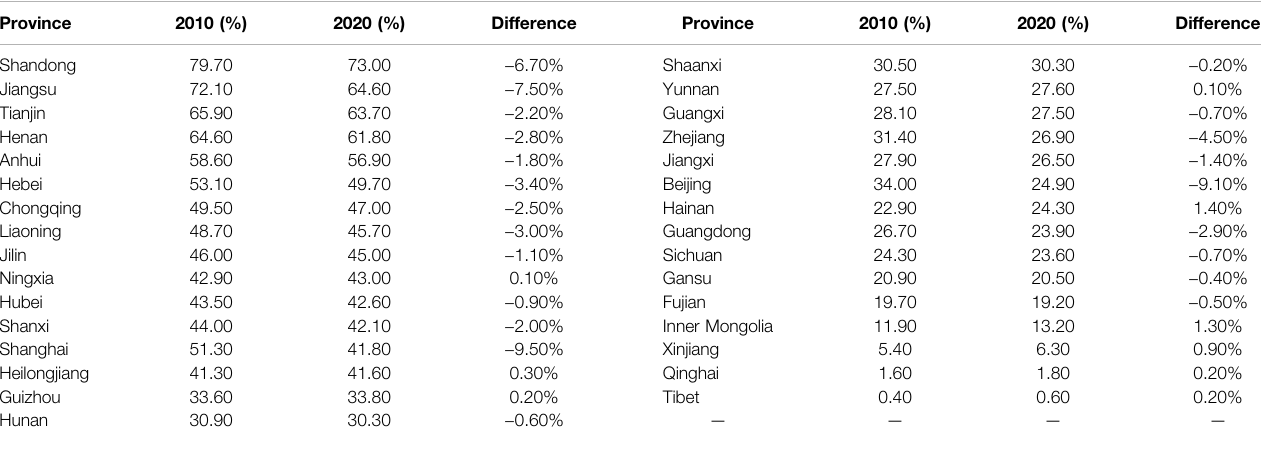
TABLE 2 | The reclamation index of 31 regions in China during 2010 – 2020.